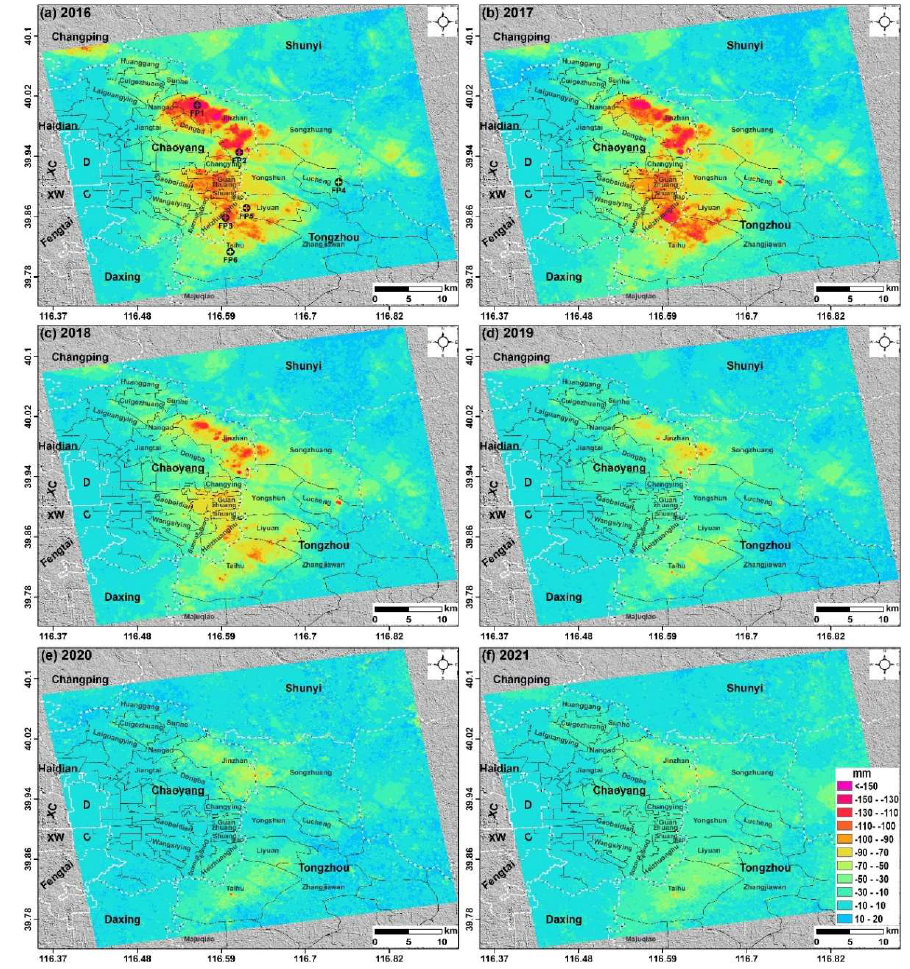
Figure 6. The distribution characteristics of land subsidence at different stages (( a ) 2016, ( b ) 2017, ( c ) 2018, ( d ) 2019, ( e ) 2020, and ( f ) 2021) during the observation period in the eastern Beijing plain.